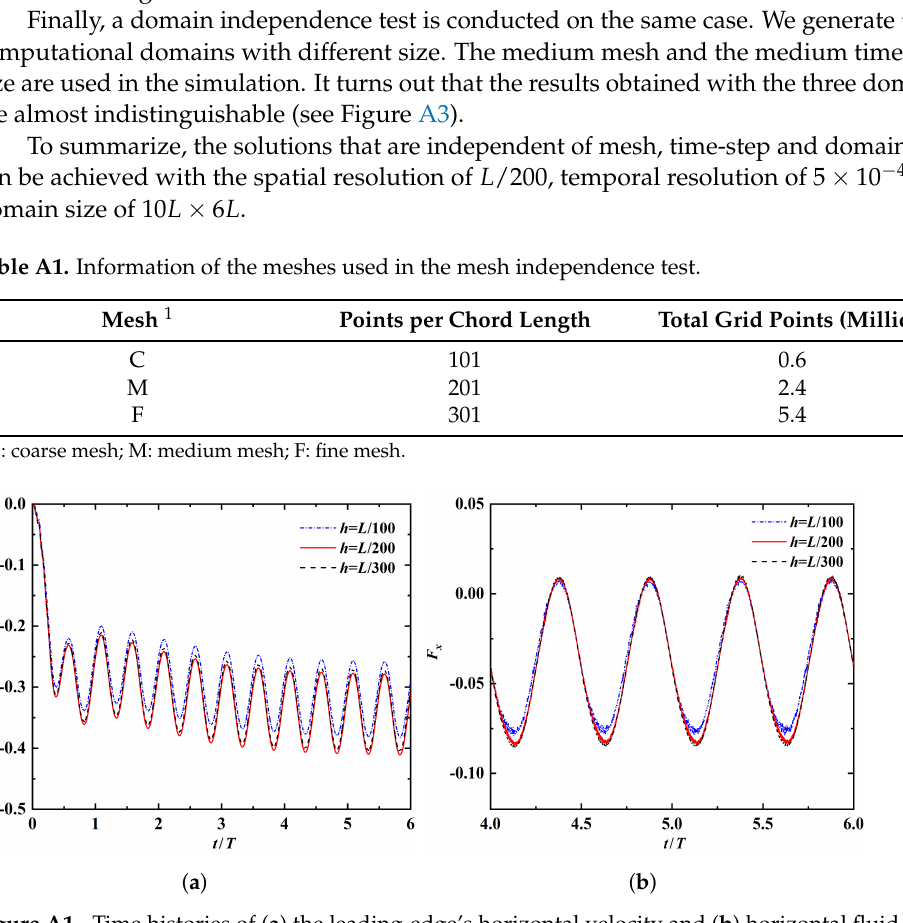
Figure A1. Time histories of ( a ) the leading-edge’s horizontal velocity and ( b ) horizontal fluid force, obtained by using three different meshes.